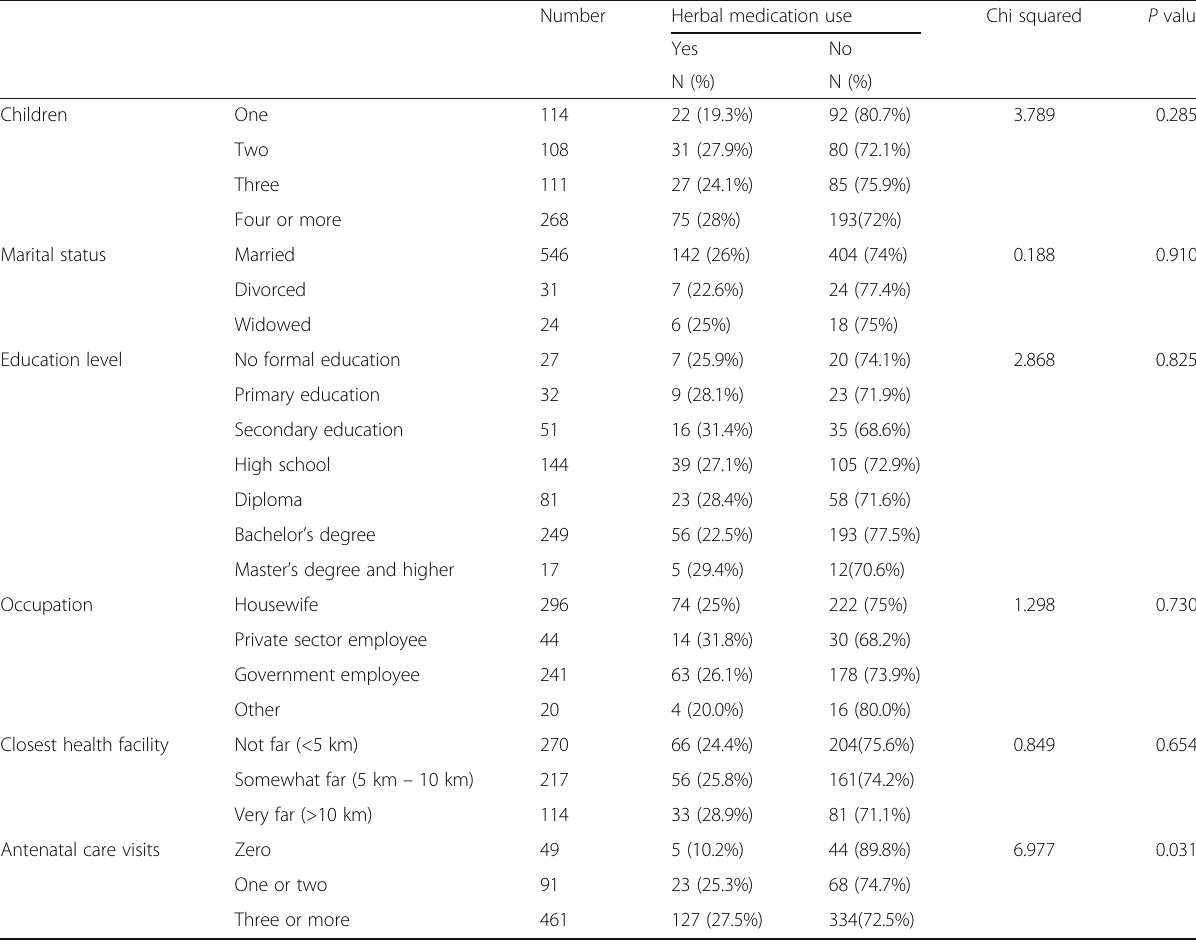
Table 2 Association between herbal medication use during pregnancy and sociodemographic characteristics